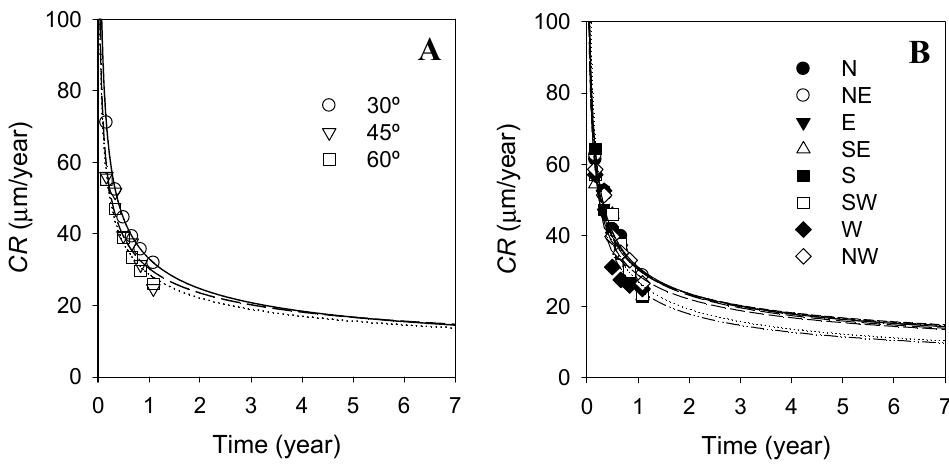
Figure 3. Data fitting to the bi-logarithmic law for the corrosion rates of carbon steel panels exposed with varying: ( A ) exposure angles with respect to the horizontal, and ( B ) orientations. Table 5. Values of the k and n constants for the potential law model ( CR in µ m / year) and fit quality. Constants